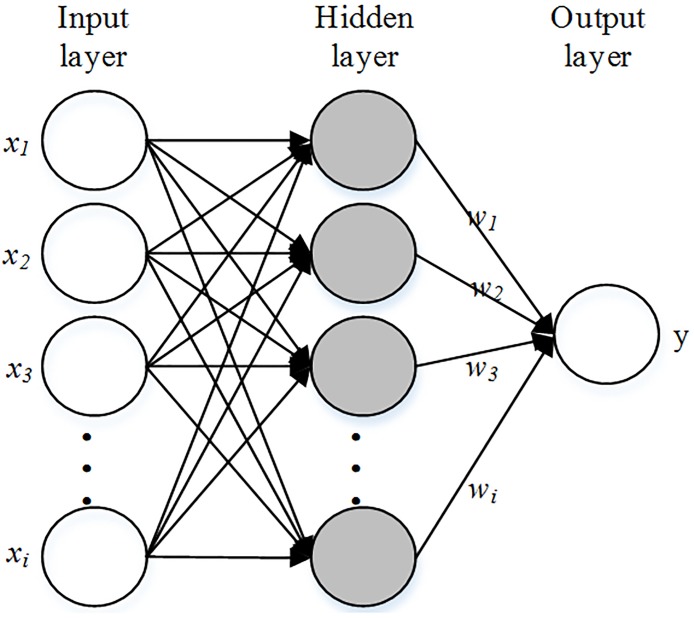
Structure of RBF[22].